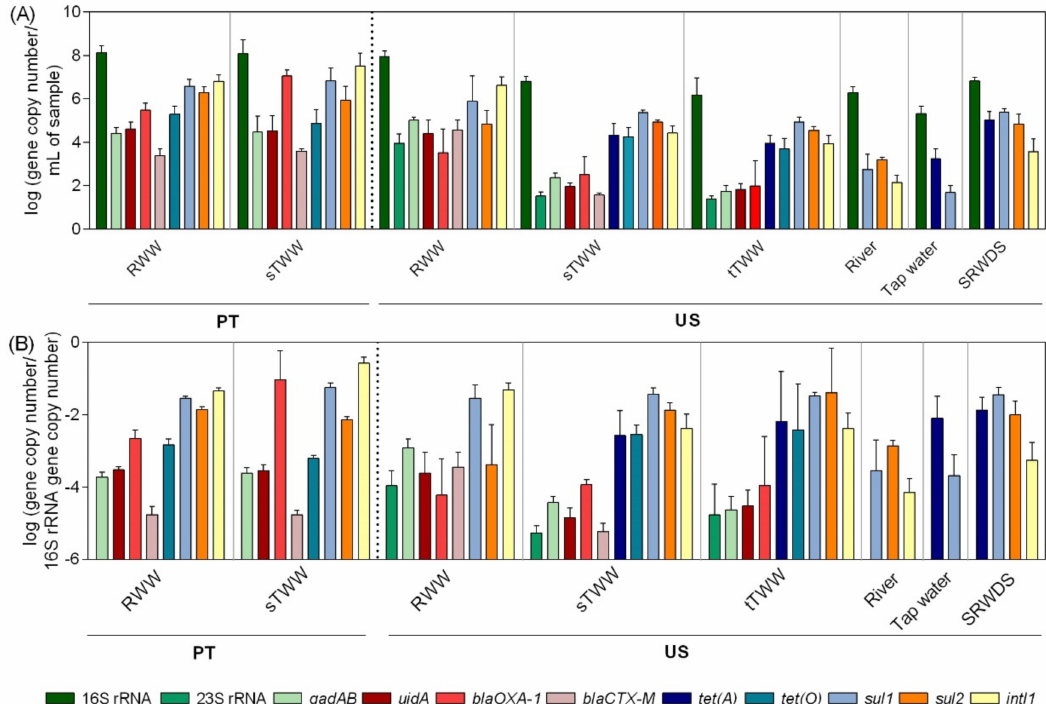
Figure 2. Genes absolute and relative abundance values across the water samples analysed.( A ) Absolute abundance (gene copy number / mL of sample) and ( B ) relative abundance values (gene copy number / 16S rRNA gene copy number) of the analysed genes in six water systems. RWW: wastewater treatment plant influent, sTWW: wastewater collected after secondary wastewater treatment, tTWW: